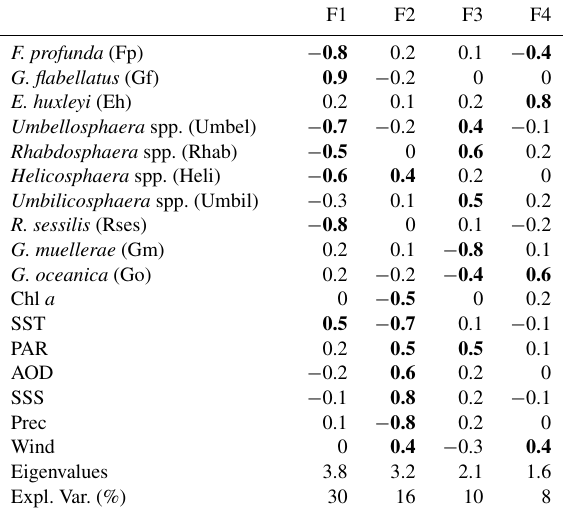
Table 3. Factor loadings (varimax raw), eigenvalues, and percent- age of the explained variance extracted from the data matrices refer- ring to the period from October 2012 to October–November 2013 at stations M4 and M2 ( r -mode factor analysis by Statistica 13; marked loadings are > 0 . 4). Chl a – surface phytoplankton biomass, SST and SSS – sea surface temperature and salinity, PAR – photo- synthetic available radiance, AOD – aerosol optical depth, Prec – daily precipitation rate, and Wind – wind speed. In Factor 3, num- bers 7 and 12 indicate the sample reference for the time intervals